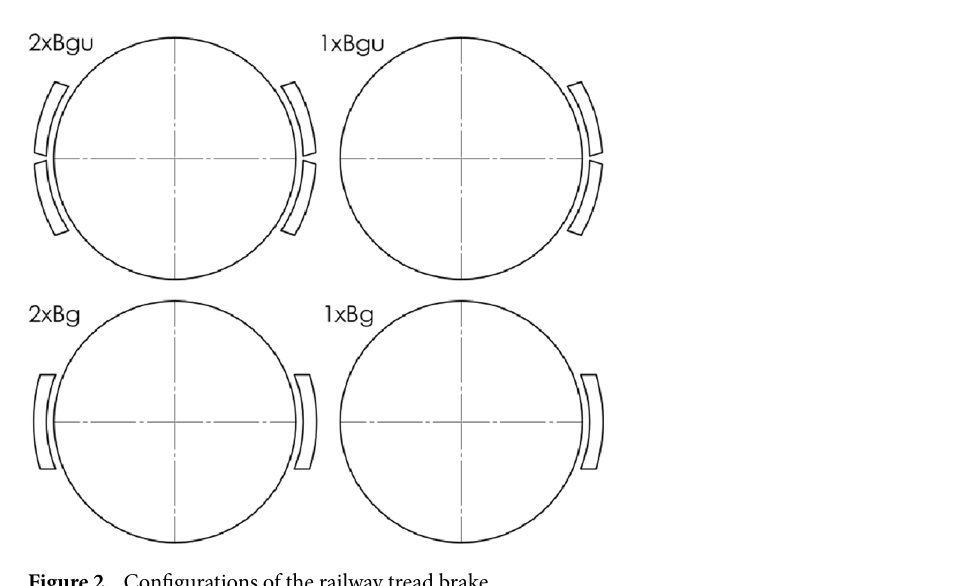
Figure 2. Configurations of the railway tread brake.